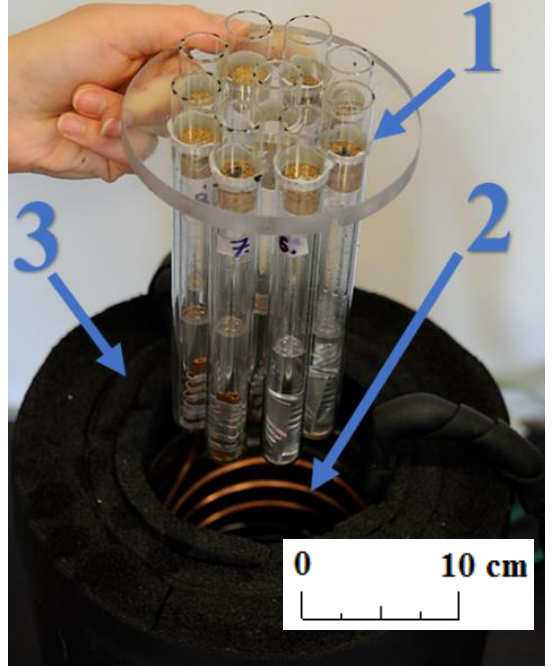
Figure 3. Photo of the experimental stand; ( 1) samples; ( 2) water bath and heat exchanger; and ( 3) insulation.